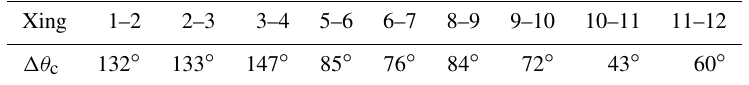
Table 3. The rotation of the cone angle for large excursions of BepiColombo in the lobes of Venus’s magnetotail. The numbering of the crossings is shown in Fig. 8.